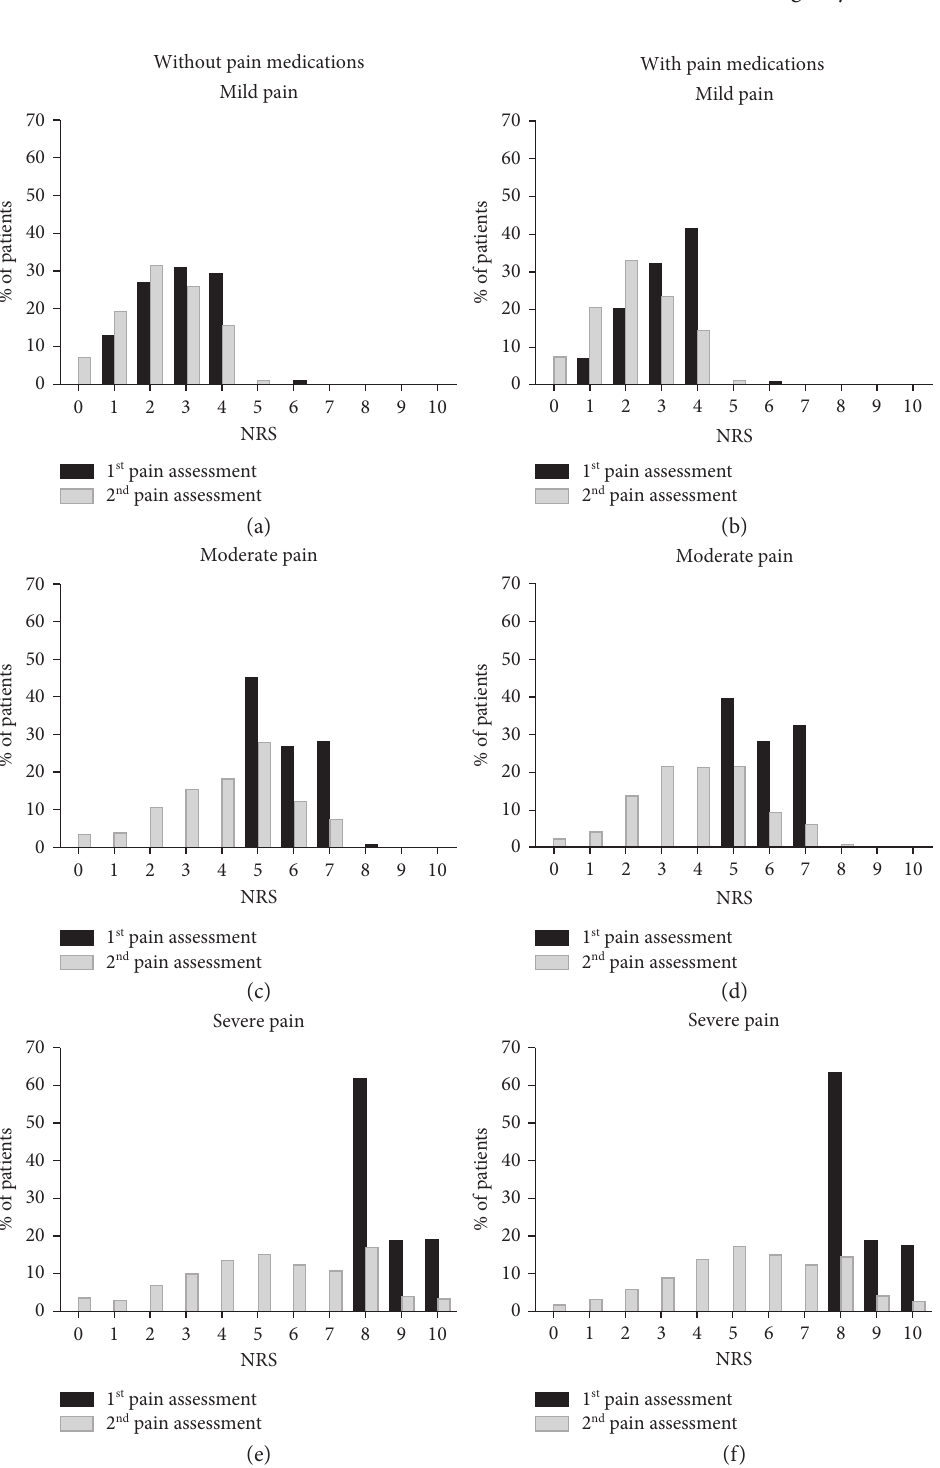
Figure 1: Pain in the group with and without medications. Patients with mild (a), moderate (c), and severe pain (e) at the first and second paramedics’ pain assessment who have not received any pain medication, and patients with mild (b), moderate (d), and severe (f) pain at the first and second pain assessment who have received nonopioid or opioid pain